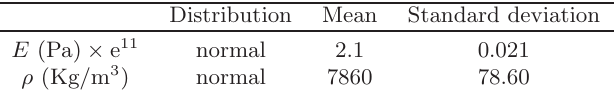
Table 2. Random variables and statistics parameters of the